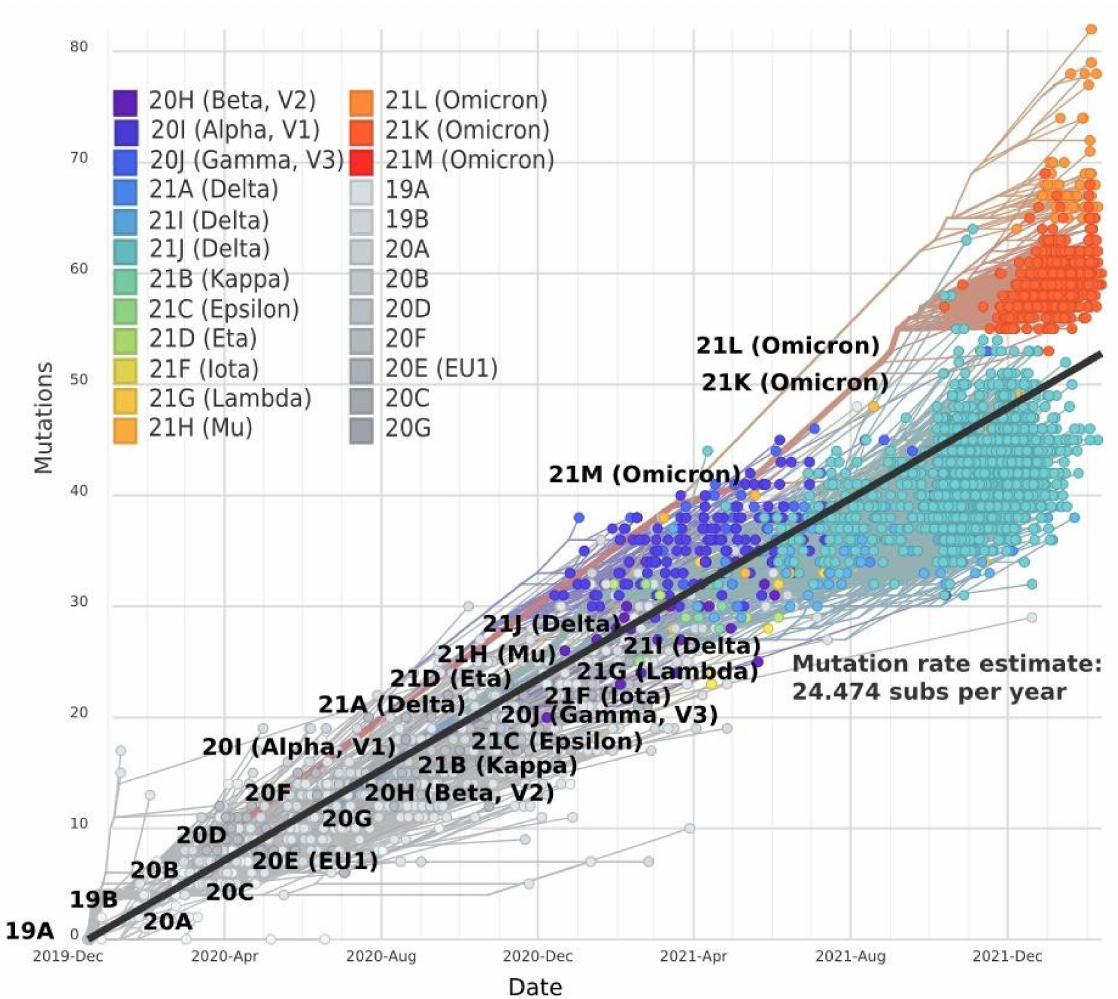
Figure 3. Time dependence of the accumulation rate of mutations in the entire SARS-CoV-2 genome constructed by NextStrain.org, according to GISAID data. Branches in phylogenetic trees were set according to NextClade classification [16]. Generated by NextStrain